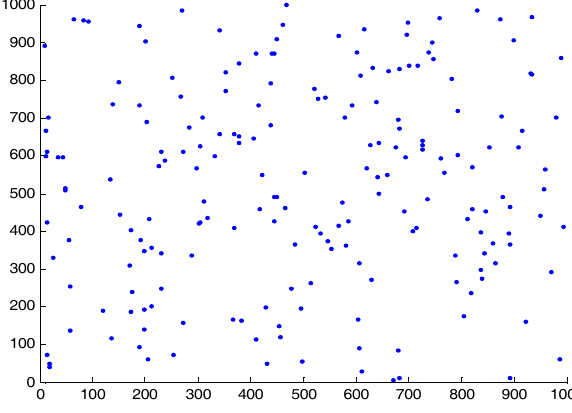
Figure 3. Node Distribution (Random) at a given time.